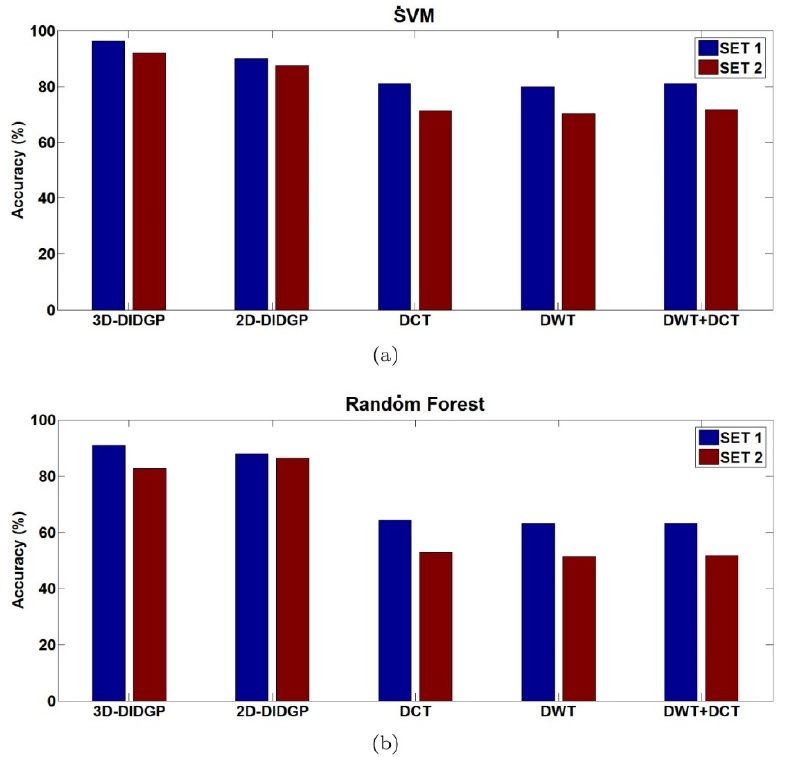
Figure 14. Comparison of classification accuracies of proposed methods on UT-Interaction dataset (Set 1 and Set2) ( a , b ) shows the accuracy of SVM and Random Forest with PCA on UT-Interaction dataset Set 1 and Set 2,